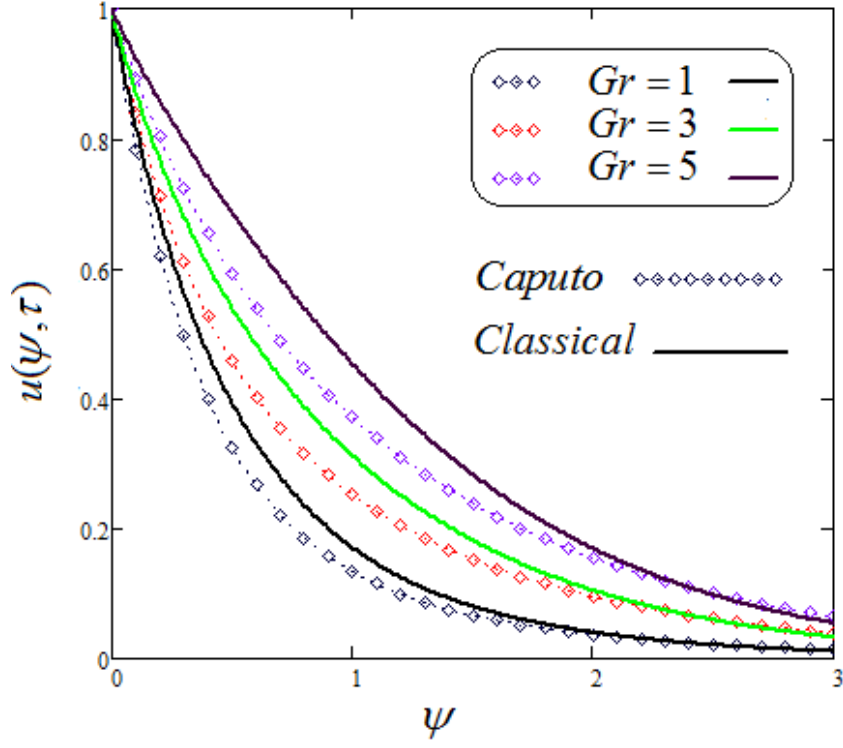
Figure 12. Trace of velocity comparison for dissimilar values of Gr